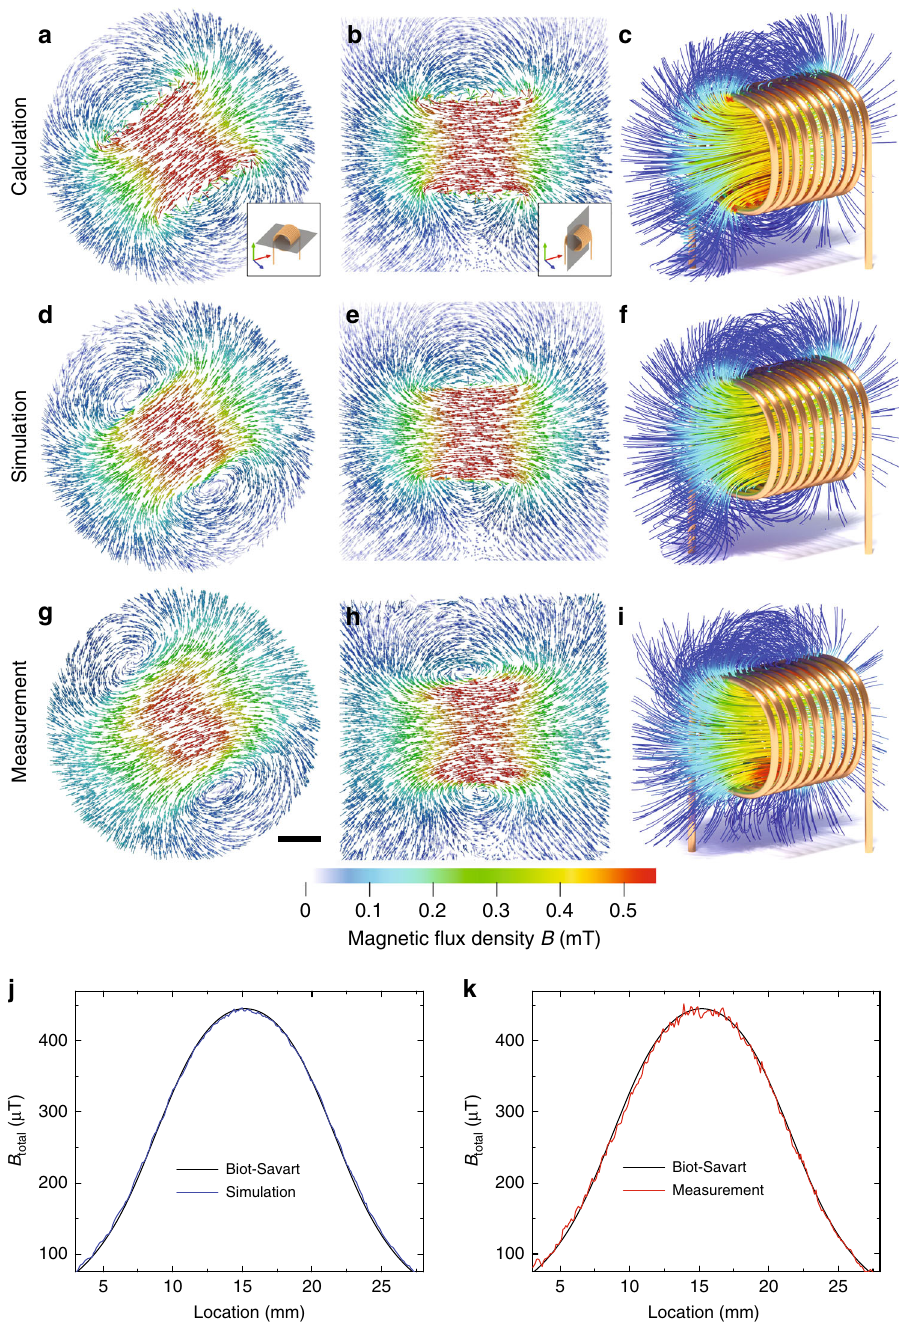
Fig. 2 Vectors of the magnetic fi eld produced by an electric coil (including leads). a – c As calculated by the Biot-Savart law, see Methods, Eq. (8). d – f TMART reconstruction of a simulated (ideal) measurement based on the theoretical fi eld distribution of a – c . g – i Measured magnetic vector fi eld distribution of the real coil. a , d , g Magnetic fi eld vectors along the horizontal plane as indicated in the inset in a and b . b , e , h Magnetic fi eld vectors along the vertical plane (see inset in b ). c , f , i 3D visualization of selected magnetic fi eld lines. Scale bar, 5 mm. j Magnetic fl ux distribution along the central symmetry axis of the electric coil. Calculated magnetic fl ux distribution (black line) and magnetic fl ux taken from the simulated measurement (blue line). k Same as j , but for the measured magnetic fl ux